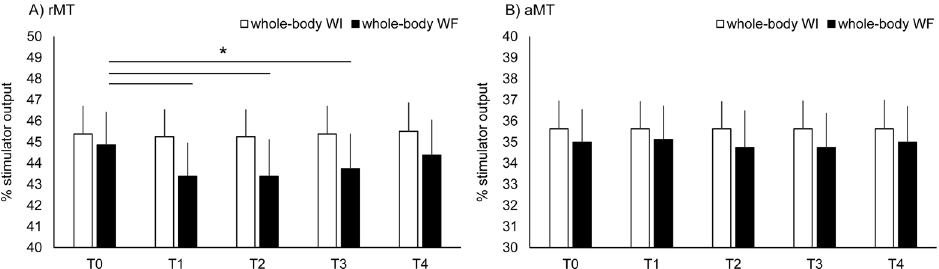
Figure 3. rMT and aMT for each intervention. White and black bars show the period of whole-body WI and WF, respectively. Asterisks (*) indicate significant differences (p , 0.05) compared with T0.